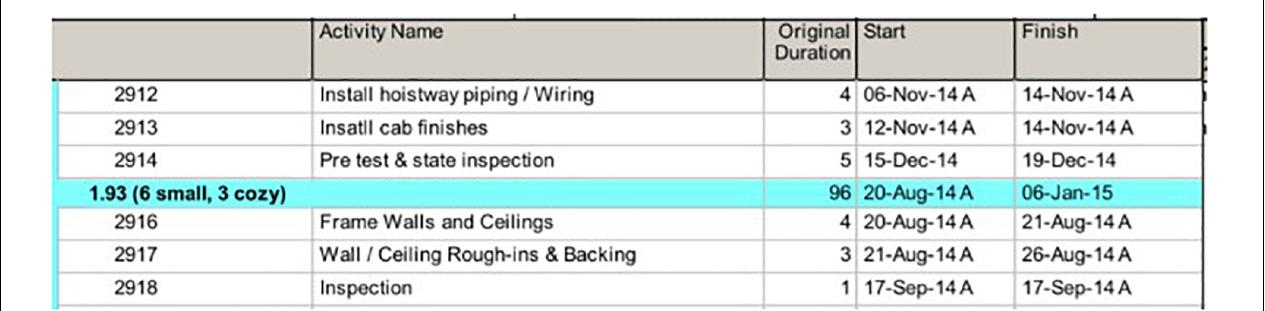
Frontiers in Built Environment |